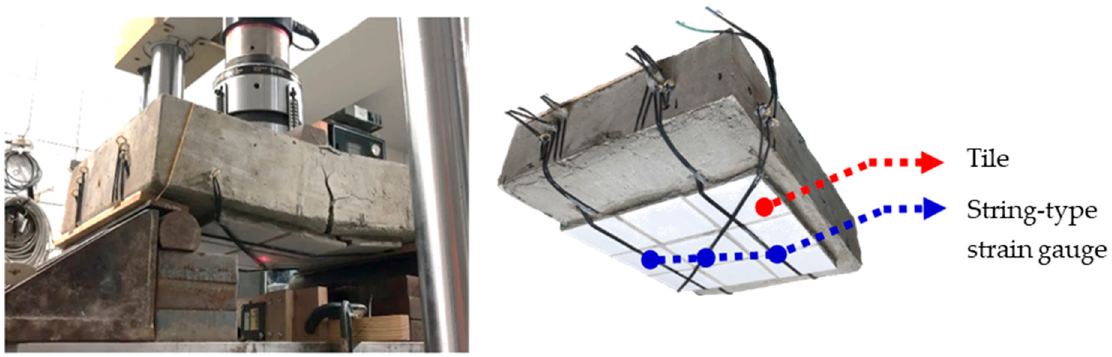
Figure 11. Compression test that used the MTS to apply force on the back of the specimen.